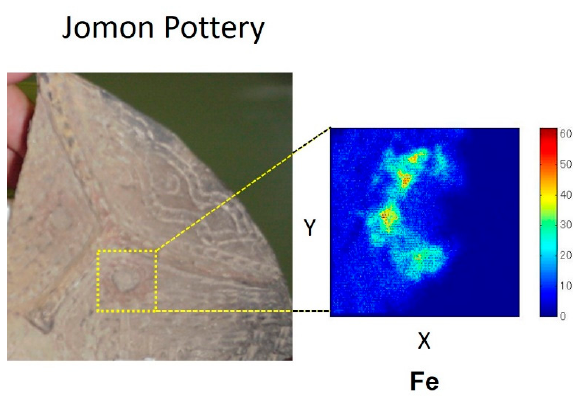
Figure 9. Spatial distributions of Ca and Fe from earthenware depicting a human face.